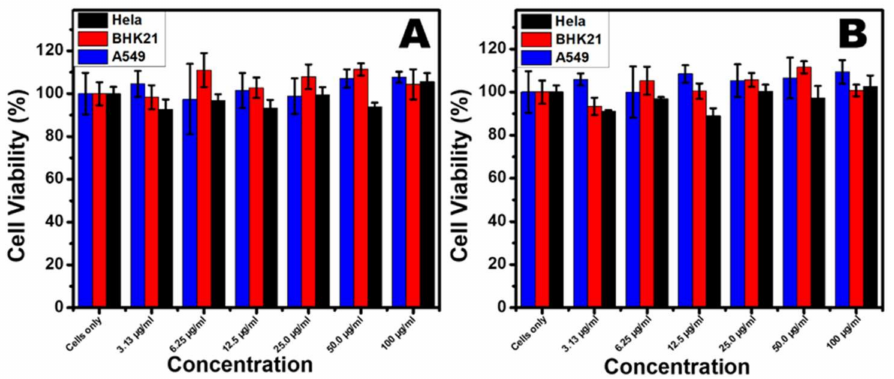
Figure 9. Cell viability results of ( A ) 1 mL CE AuNPs and ( B ) 2 mL CE AuNPs against normal kidney fibroblasts (BHK21), cancerous cervical HeLa cells, and Lung cancer cells